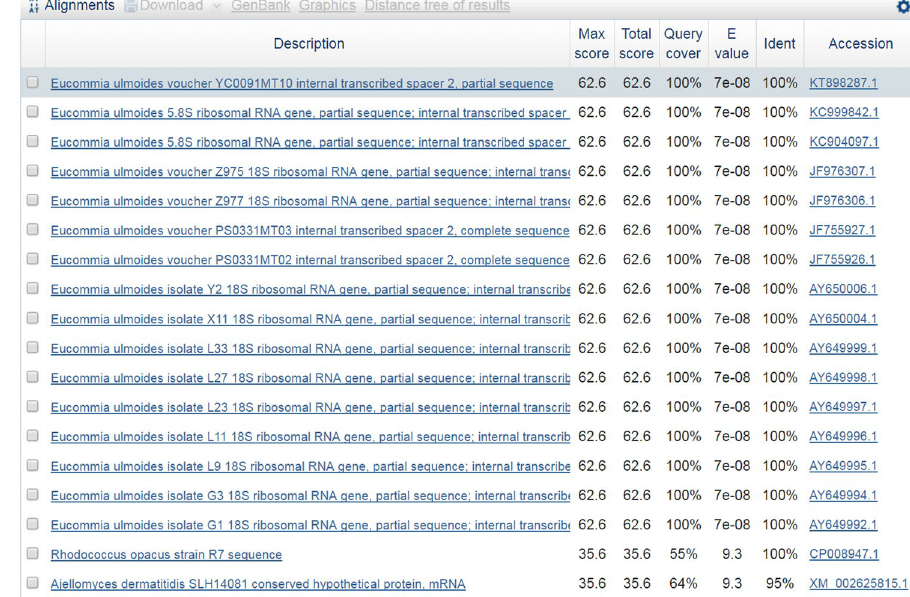
Figure 1. The alignment of the 34-nucleotide conserved region.